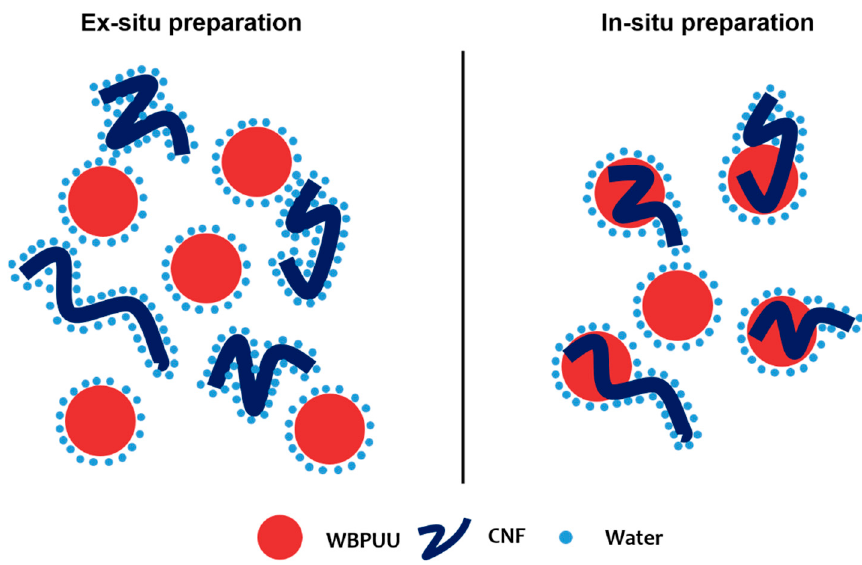
Figure 3. Schematic representation of interactions taking place through different preparation methods.